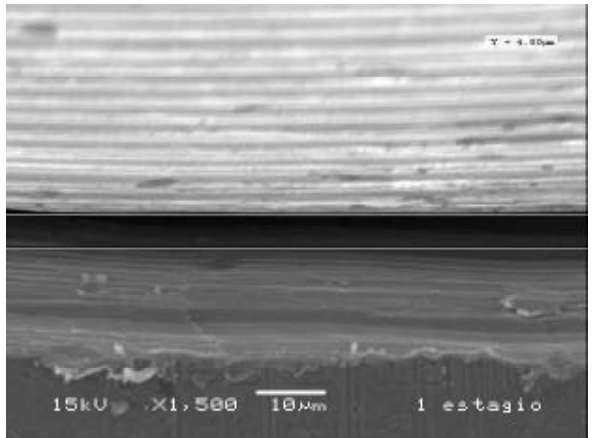
FIGURA 10- Observação da fenda (seta) no sentido longitudinal no sistema de dois estágios (x200)